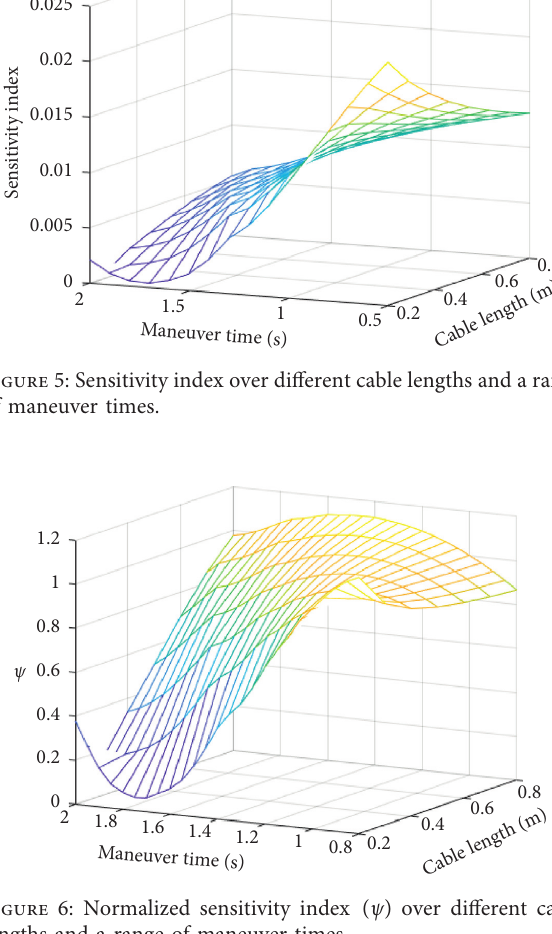
Figure 6: Normalized sensitivity index ( ψ ) over different cable lengths and a range of maneuver times.